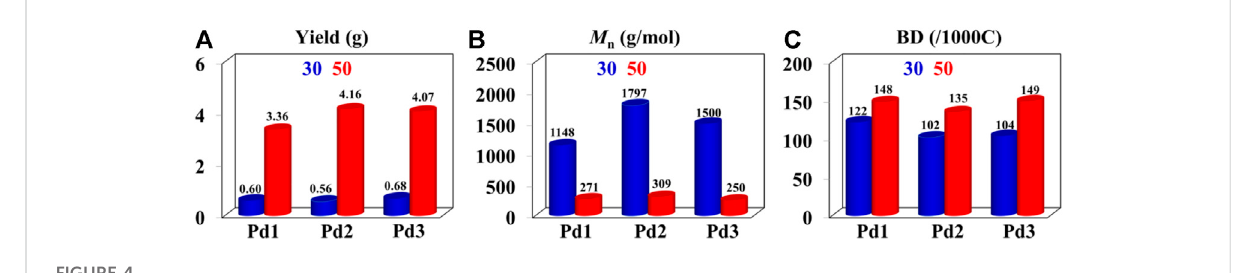
FIGURE 4 Comparisons on yield (A) , molecular weight (B) , and branching density (C) of ethylene oligomers produced by Pd1 - Pd3 at 30 ° C (bule) and 50 ° C (red).